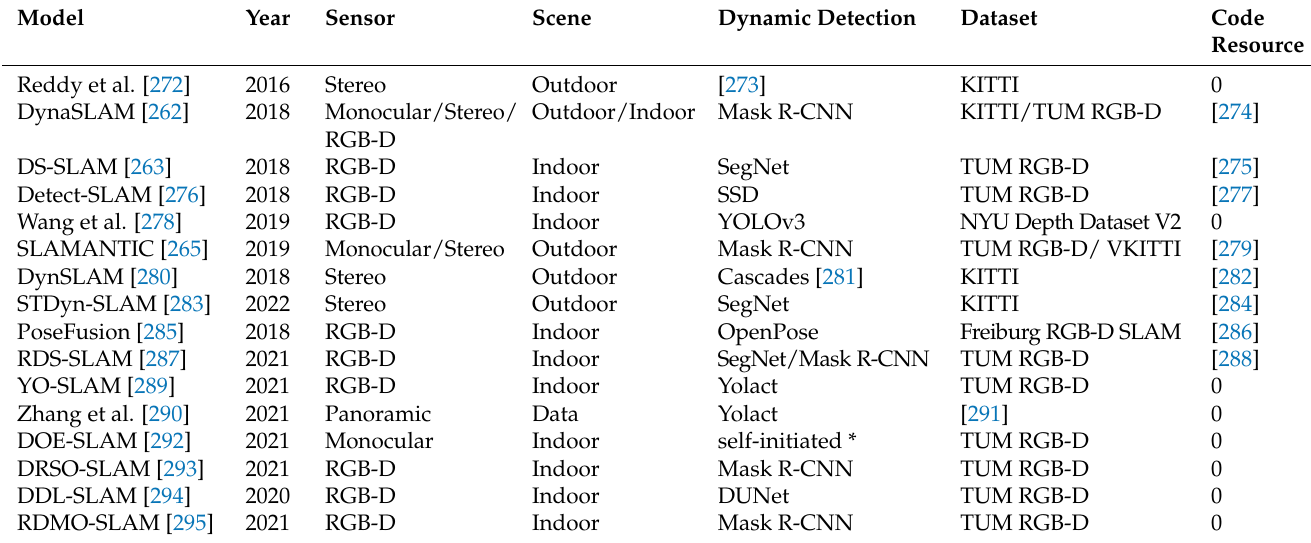
Table 14. Some excellent VSLAM algorithms for dynamic scenarios in recent